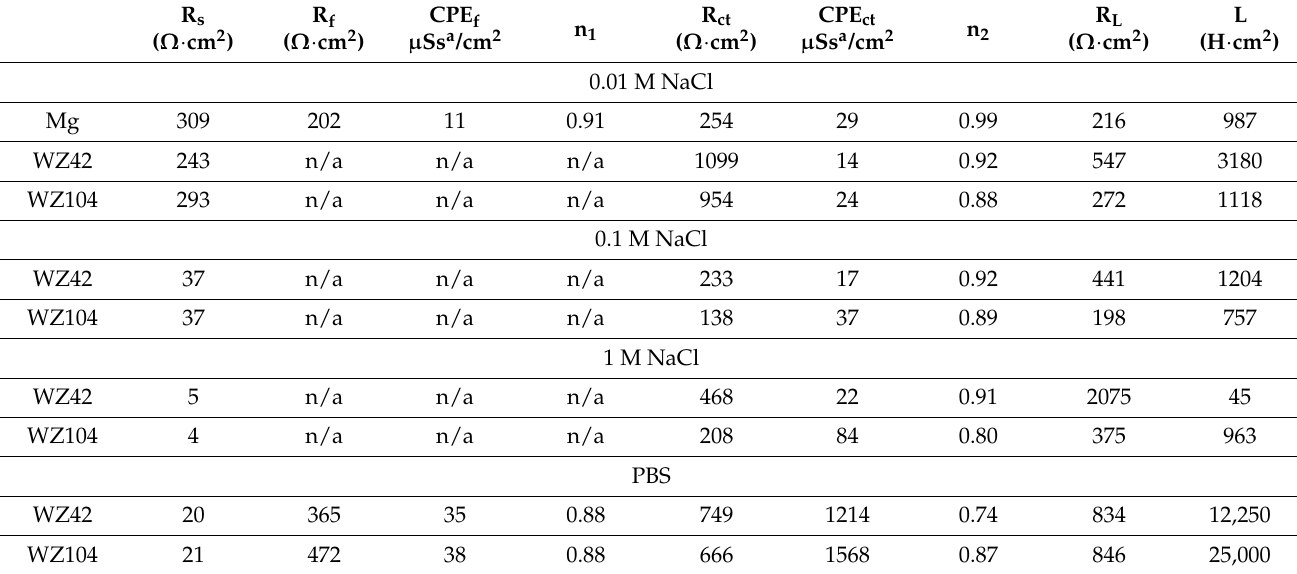
Table 3. Characteristic electrochemical parameters delivered from EIS data fitting with the use of equivalent electronic circuits presented in Figure 7 after 1 h of immersion under aerated conditions